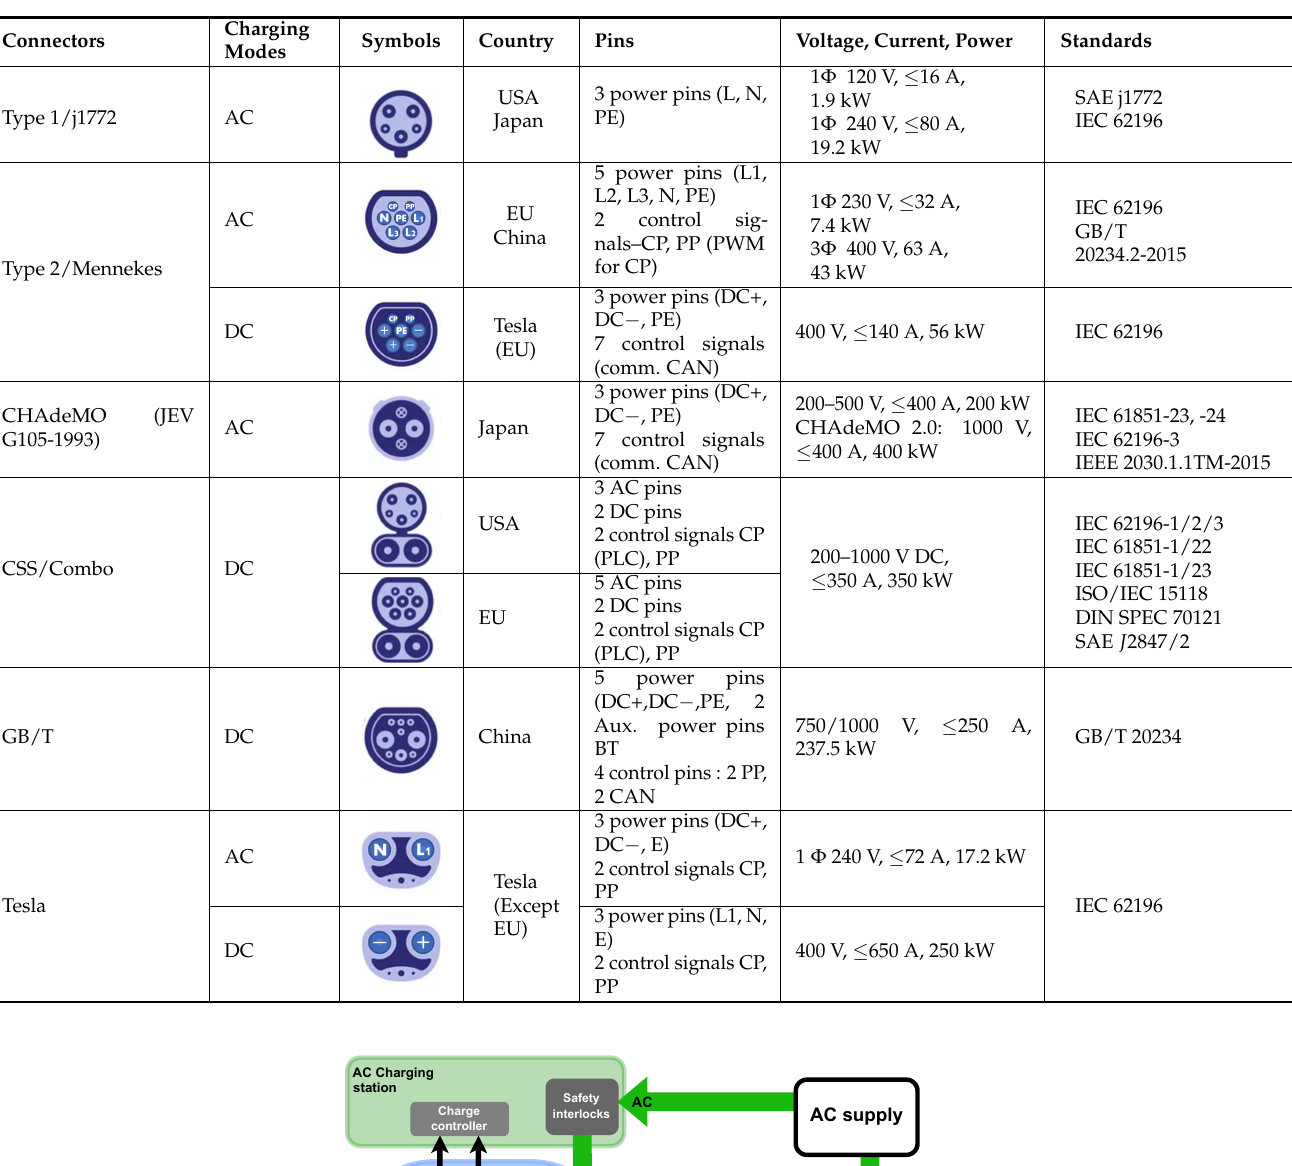
Table 4. Types and standards of charging connectors.